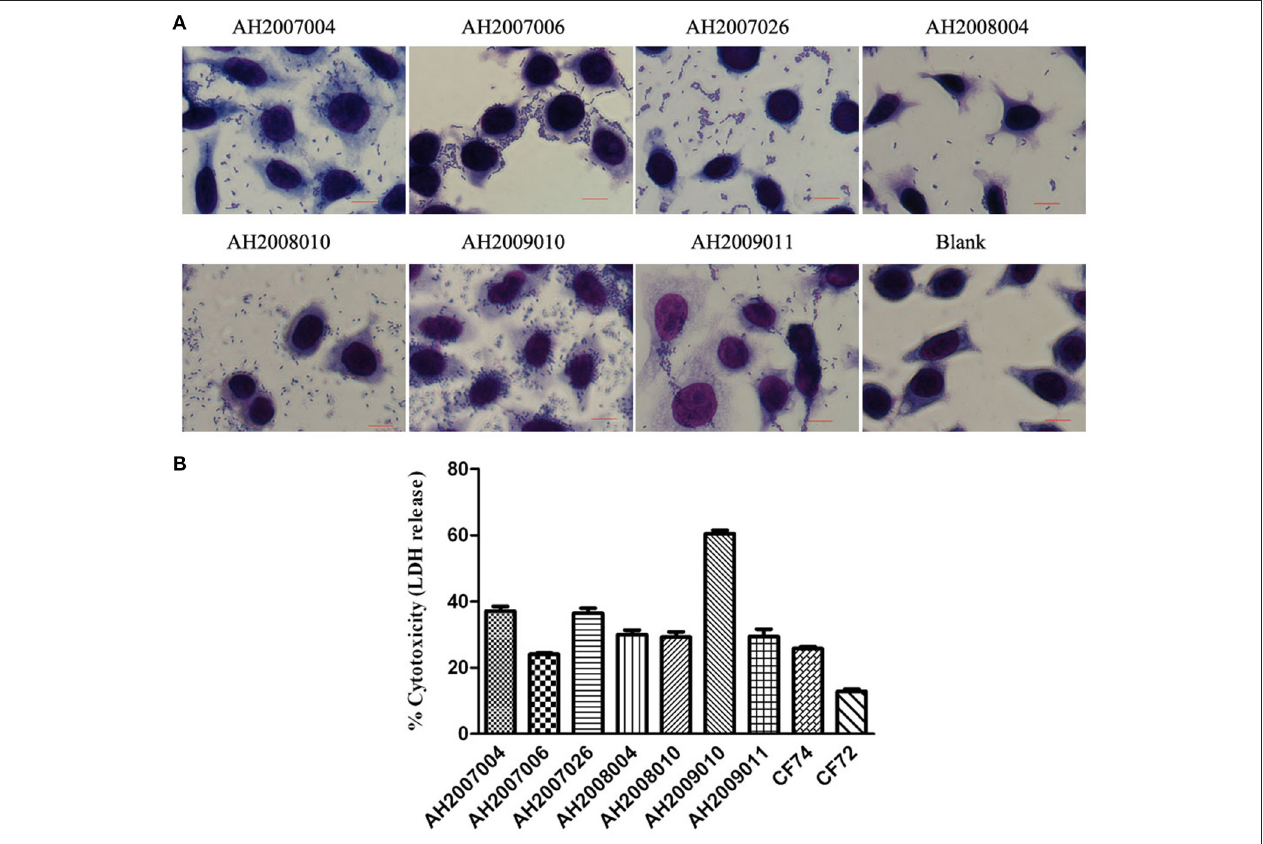
FIGURE 2 | HEp-2 cell adhesion and cytotoxicity of Citrobacter isolates. (A) Light micrographs show the adherence patterns displayed by seven cytotoxic Citrobacter isolates. Blank as negative control. Bar: 10 µ m. (B) Cytotoxicity was based the LDH released from HEp-2 cells after exposure to cytotoxic Citrobacter isolatesat 8 h. CF72 and CF74 were control